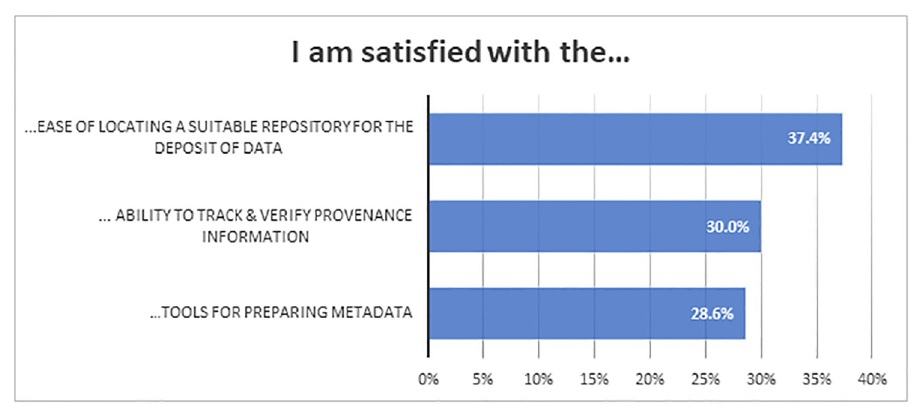
Fig 6. “I am satisfied with the ... ”. (Locating suitable repository n = 1812; provenance information n = 1803; tools for preparing metadata n = 1808).